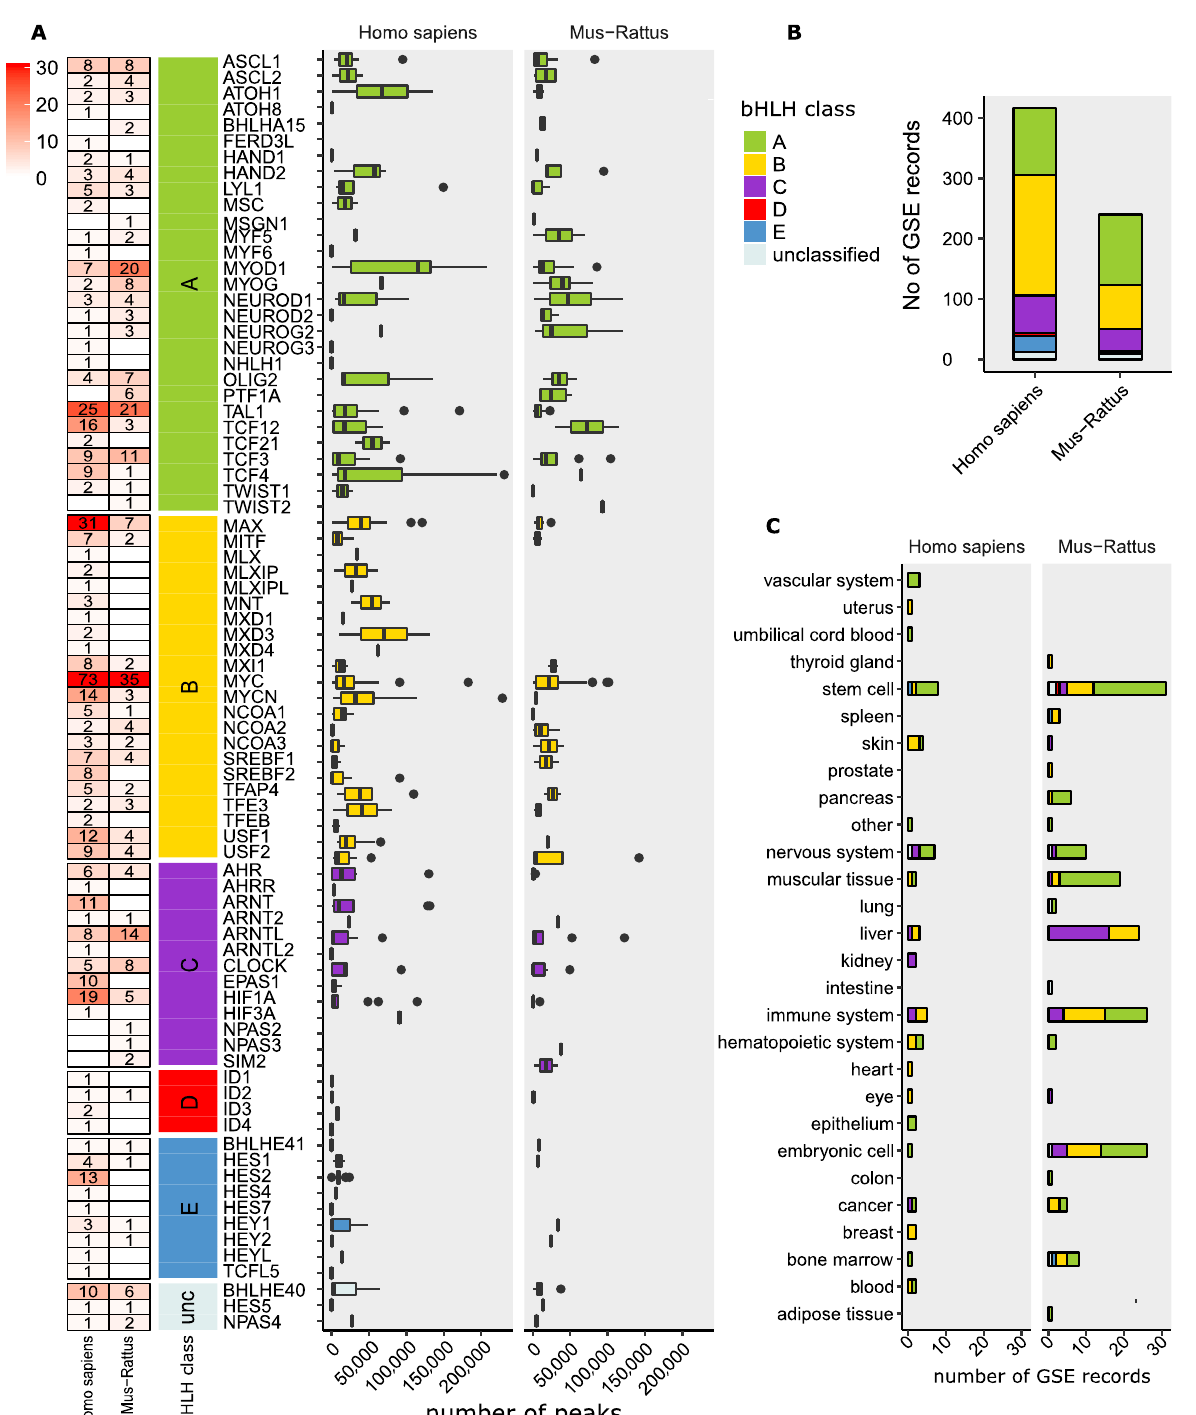
Figure 5. Summary measures of ChIP-seq experiments conducted on bHLH TF using data collected from GTRD (https://gtrd.biouml.org, accessed on 17 May 2021) ( A ) Number of GSE records for each available bHLH transcription factor (32 had no available data in GTRD, see Table S1. Boxplot shows the number of peaks detected by MACS2 for each transcription factor averaging over the sum of experiments with the same GSE record ID, variability of numbers could reflect technical or biological differences among conditions and replicates. ( B ) The number of studies conducted in each class of bHLH in humans and rodents. ( C ) Barplot showing the distribution of tissues evaluated by ChIP-seq experiments stratified by species and representing the contribution of each bHLH